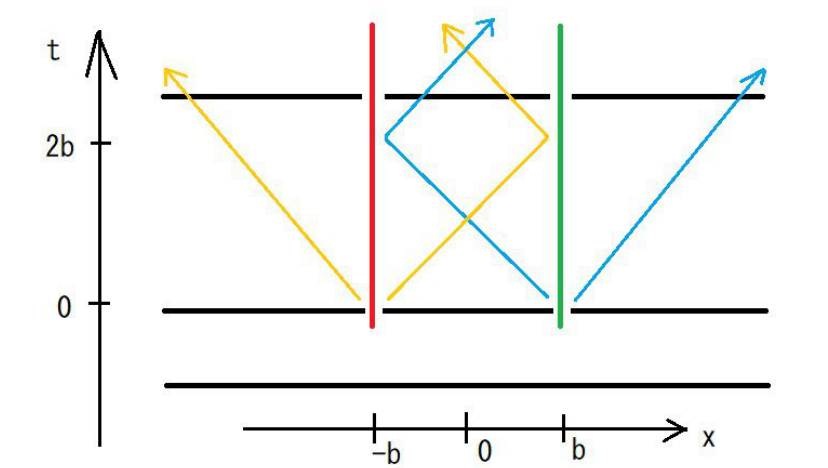
Figure 39 . Sketch of a quasi-particle picture. Since single quench creates two quasi-particles, double splitting quench creates four quasi-particles, which is described by blue and yellow lines. These particles move at light speed. Two particles go away from quench point and the other two are trapped in the interval [ b; b (cid:0)